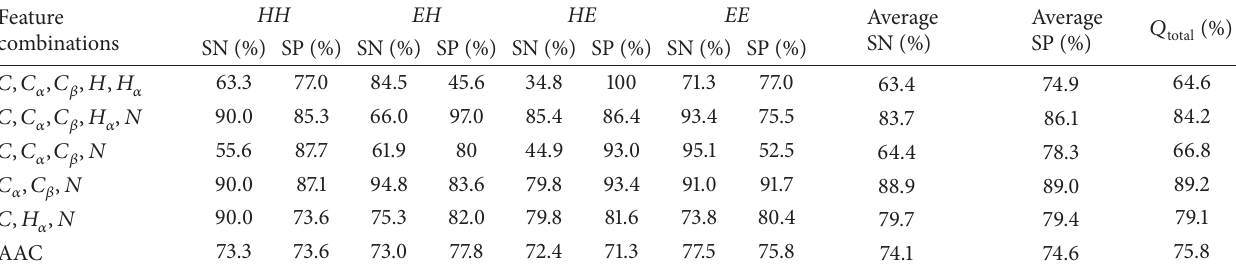
Table 2: Predicted results of different feature combinations ( 𝑅 < 0.4).